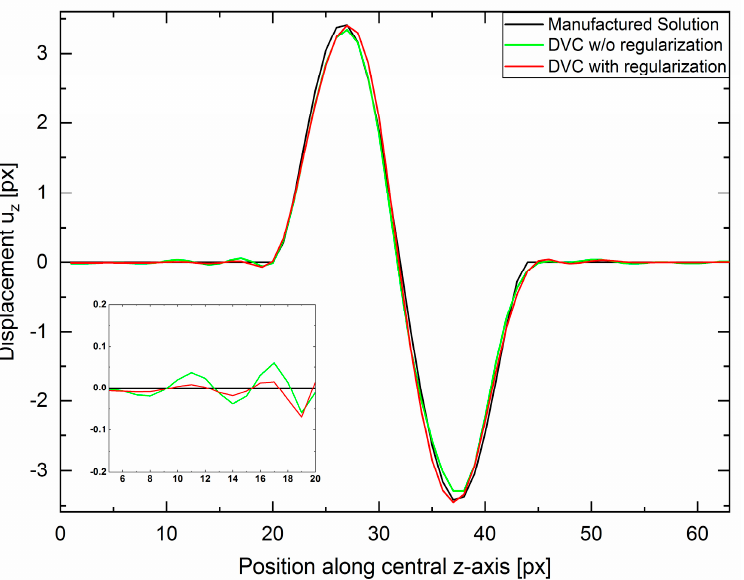
Figure 5. Line profile of the displacement from the central slice along the z-direction as indicated by the arrow in Figure 4c. Improvement of overshooting and ringing by use of regularization. The insert magnifies the left tail indicating a reduction in overshoot and subsequent ringing. No decrease in maximum amplitudes can be identified by using regularization.